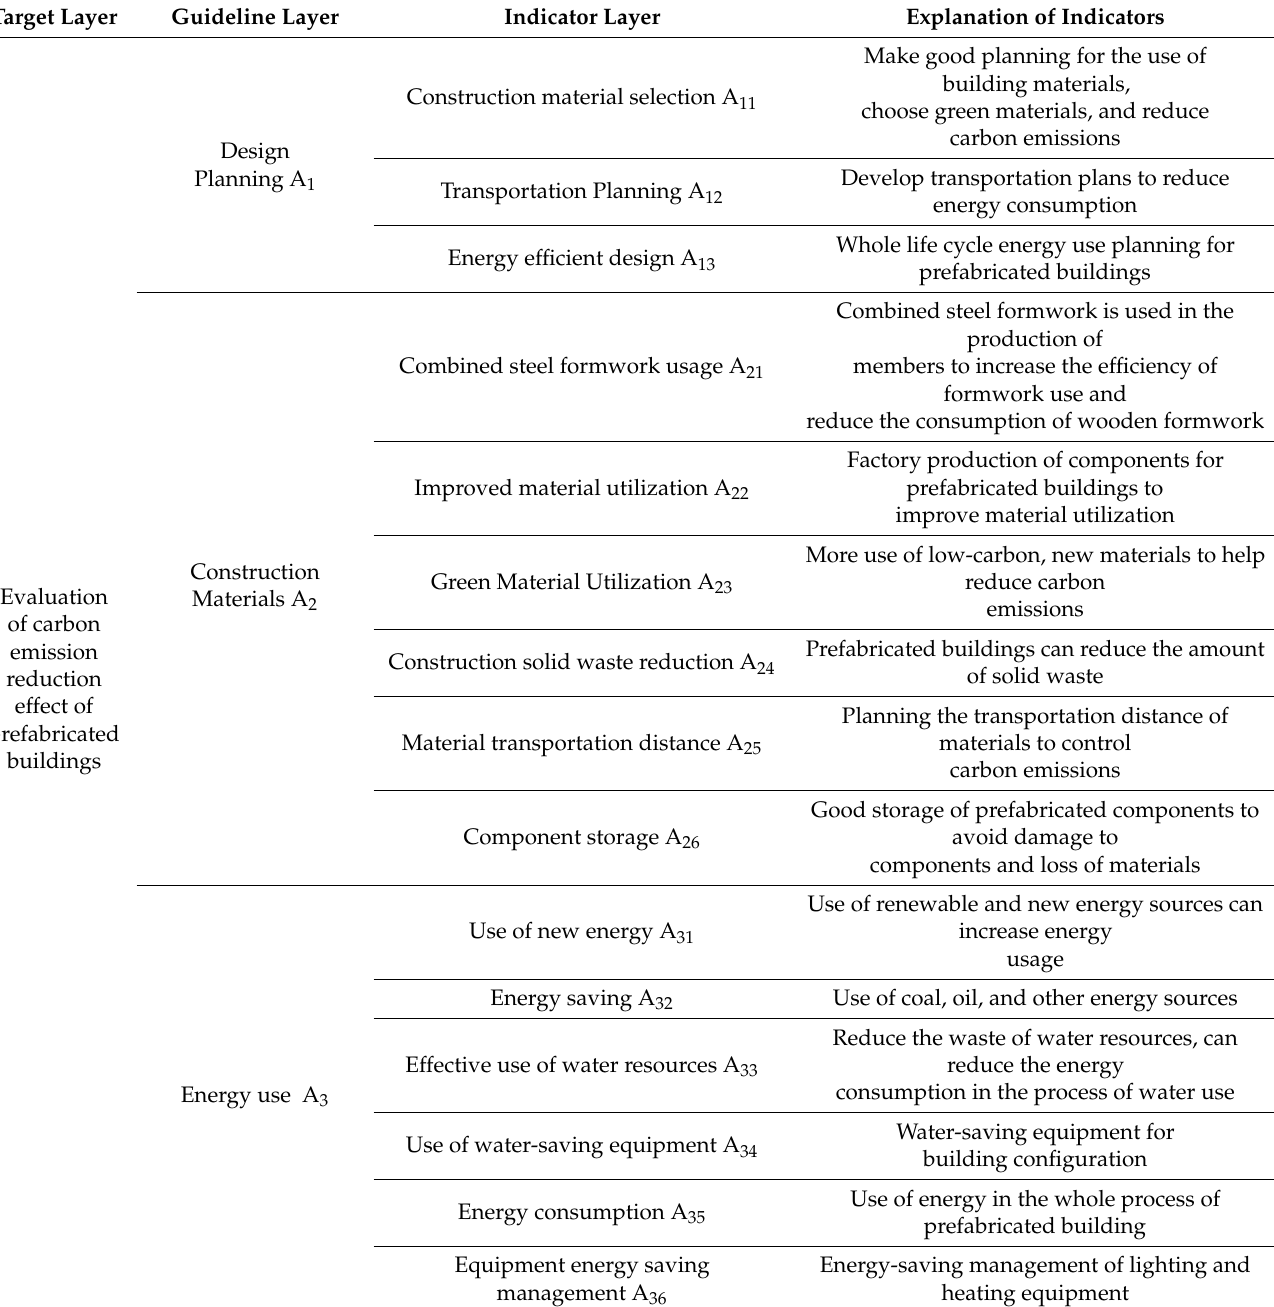
Table 2. Carbon emission reduction impact factors of prefabricated